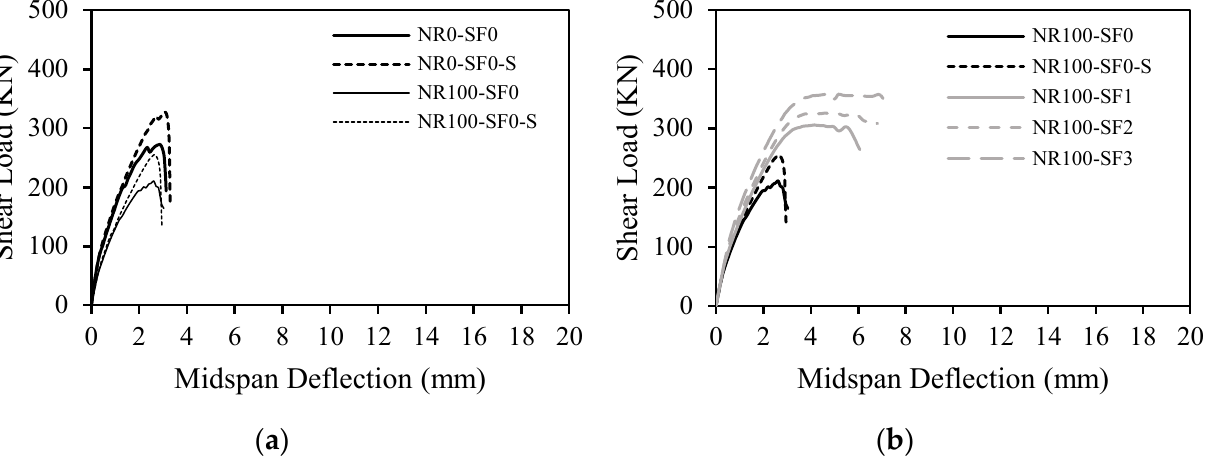
Figure 13. Numerical shear load–deflection responses of group N: ( a ) beam models without steel fibers; ( b ) beam models with RCAs/steel fibers.